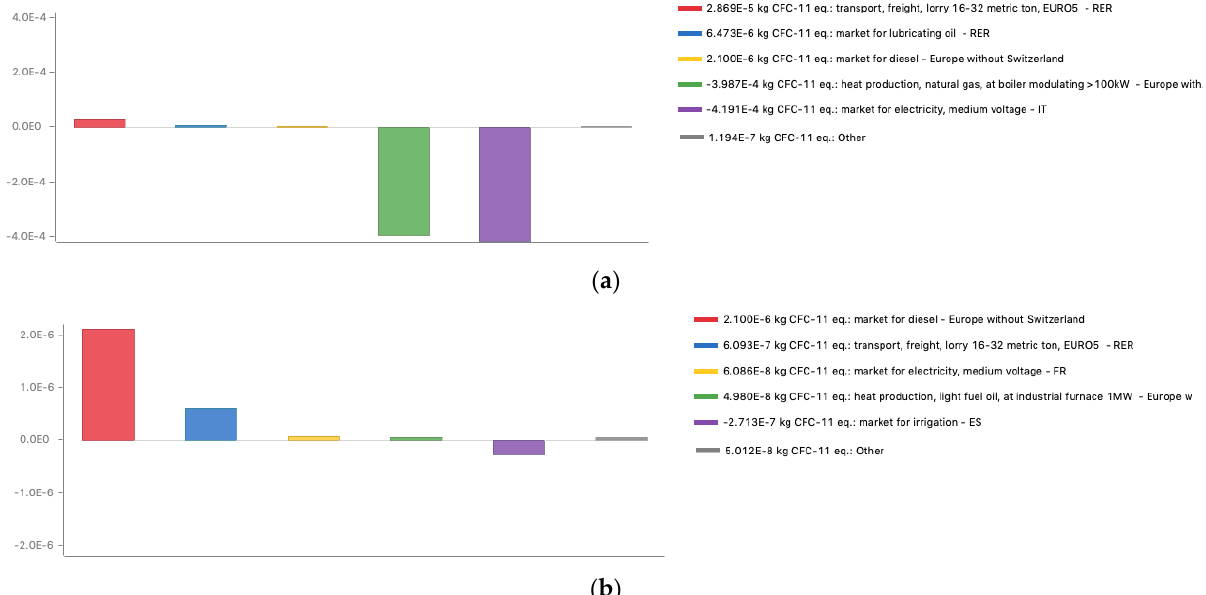
Figure 11. Ozone layer depletion: top 5 contributions impacting category results: ( a ) Cradle-to-grave analysis; ( b ) Downstream process.